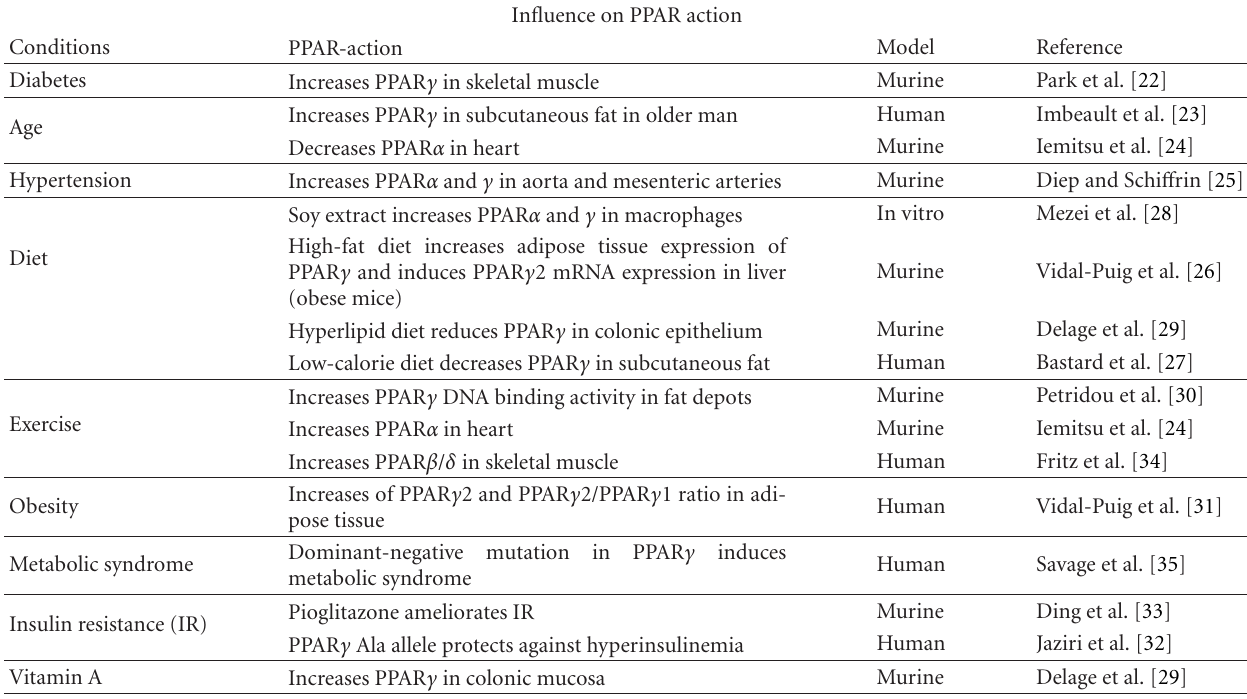
Table 1: E ff ects of physiological and pathophysiological conditions on PPAR.